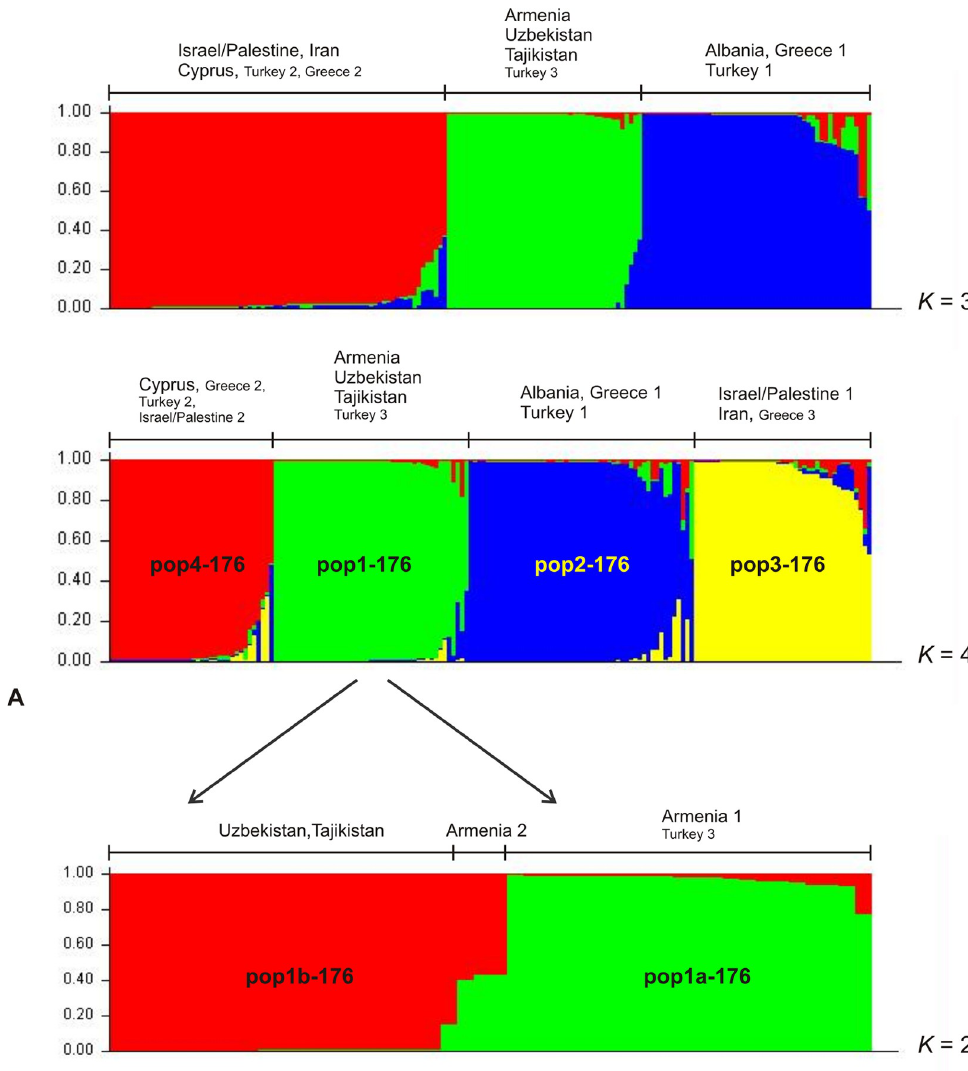
Fig 4. Estimated population structure of a subset of 176 L . infantum MON1 strains most closely related to the Armenian strains as inferred by Bayesian analysis of their MLMT profiles. In the barplots each strain is represented by a single vertical line divided into K colors, where K is the number of populations assumed. Each color represents one population. The length of the colors segment shows the strain’s estimated proportion of membership (Q) in that population. Strains are sorted by membership coefficient (Q). (A) According to Δ K the most probable number of populations is four ( K = 4), in addition also K = 3 is shown. (B) Structure of subpopulation 1 (pop1-176) comprising the strains from Armenia, Uzbekistan, Tajikistan and Turkey3. According to Δ K the most probable number of populations is two ( K =